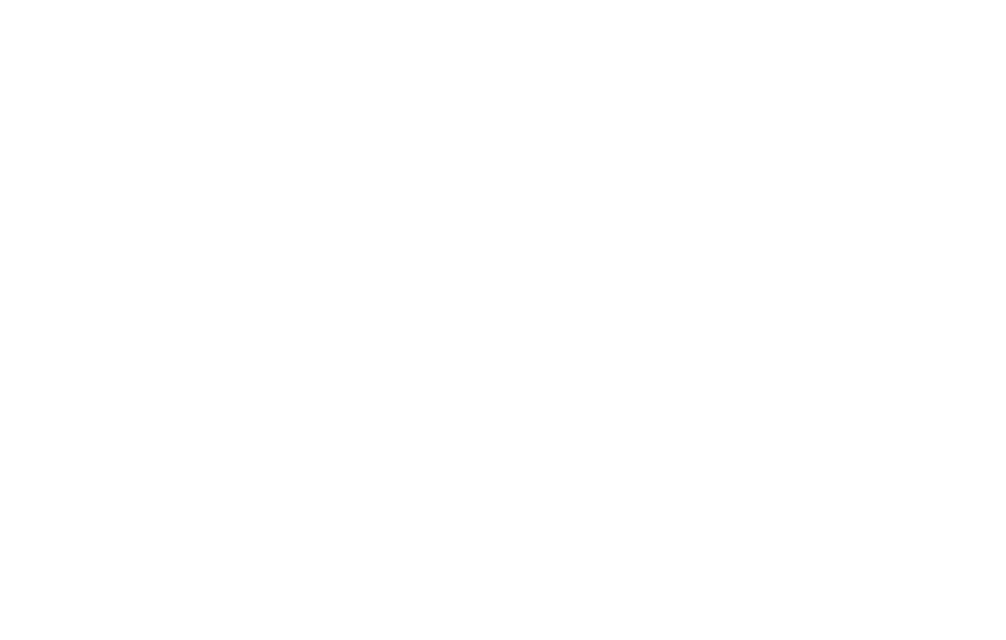
ofspikes (thesameexperiment asin A )relative tothephase ofeach respiratory cycle. Bottom: peristimulus time histogram illustrating the number of spikes fired during each respiratory cycle. ( A and B )are not